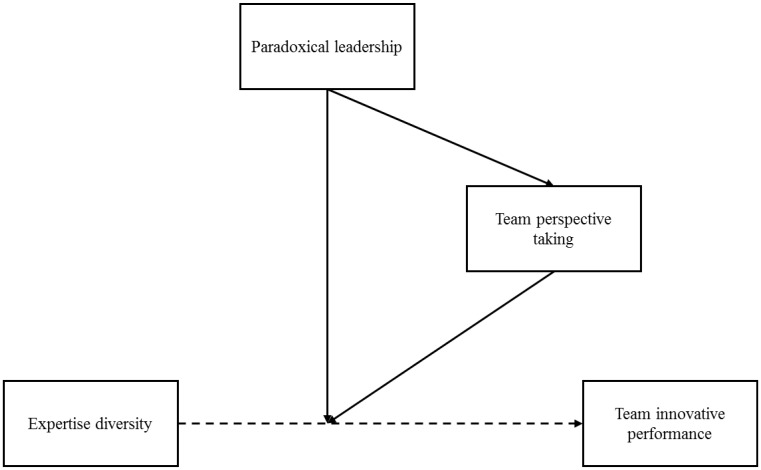
The proposed model.